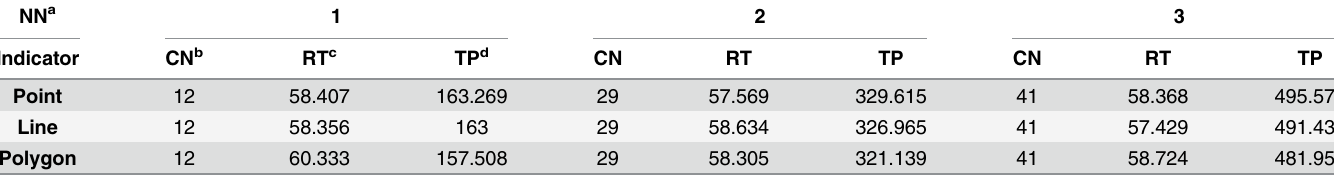
Table 2. Performance test of different clusters for polygon clip operation in single workflow.